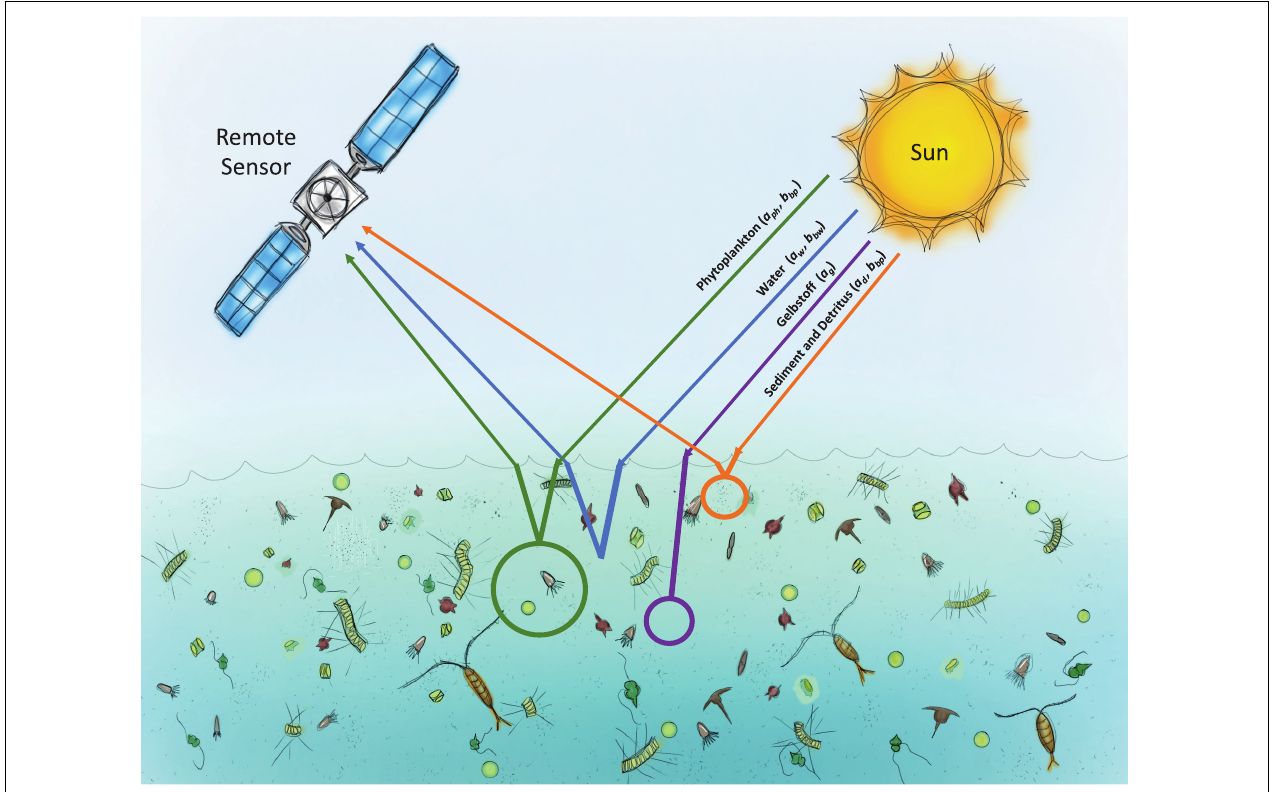
FIGURE 1 | Schematic of how common seawater constituents, including particulate and dissolved components, could both be generated and altered through the process of herbivorous